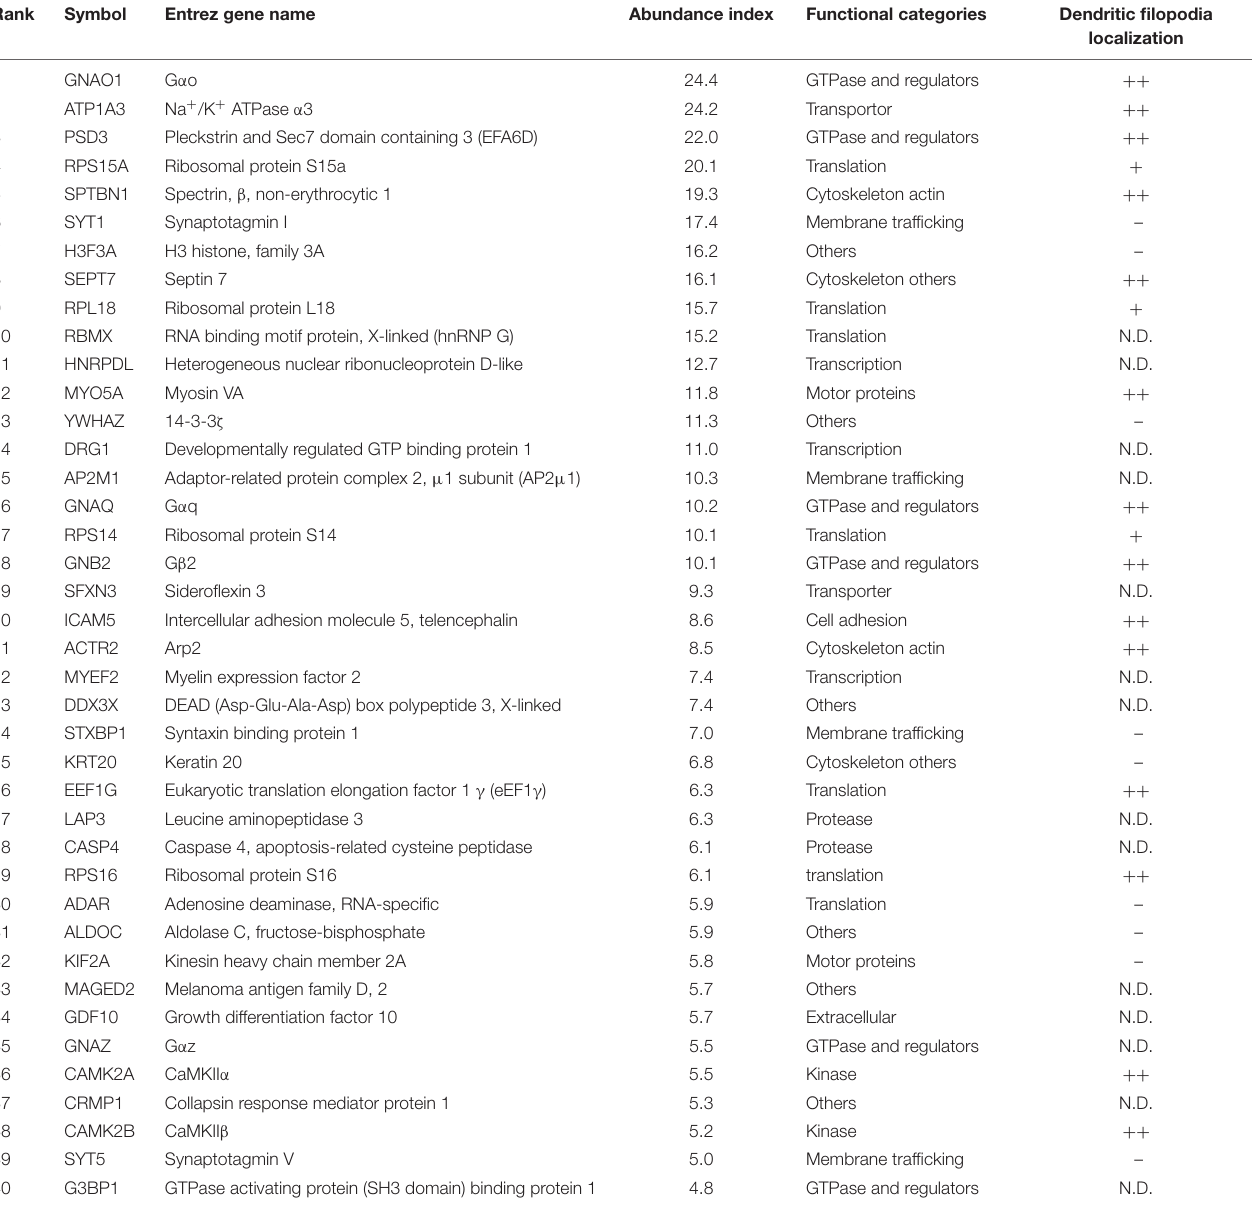
TABLE 1 | Top 40 proteins abundantly present in the dendritic phagocytic cup